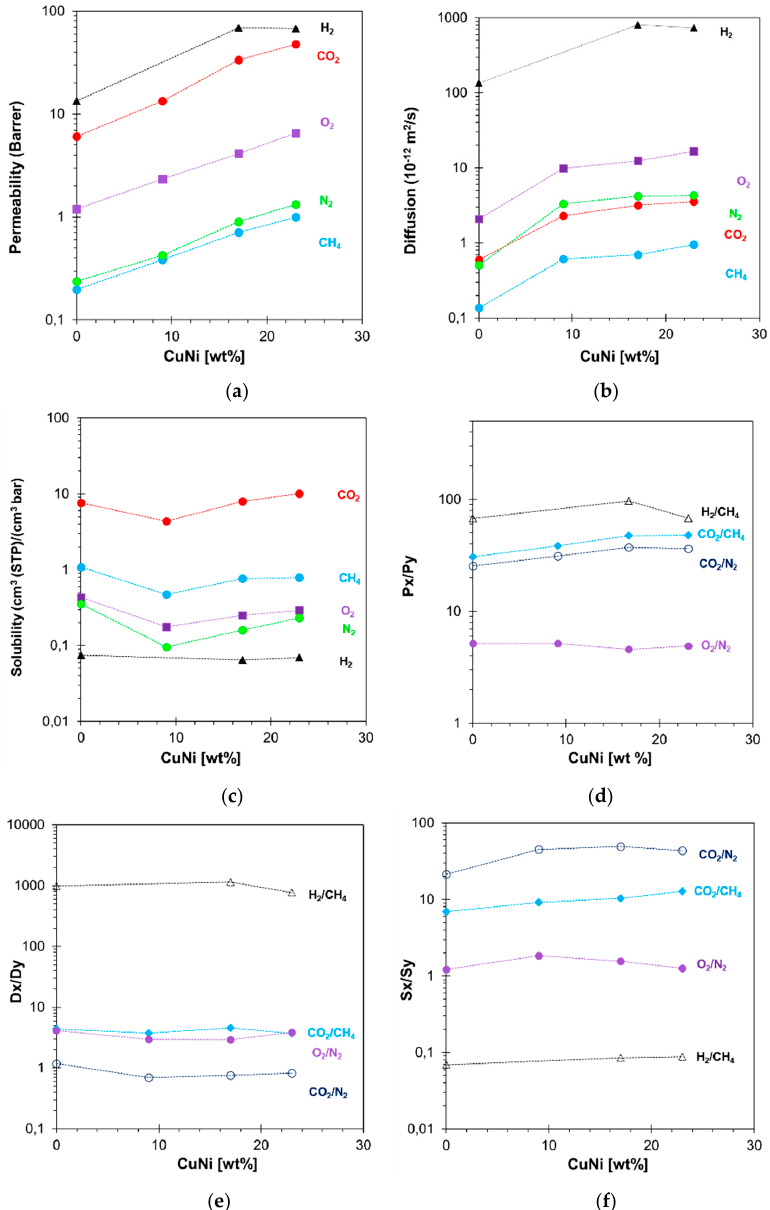
Figure 6. ( a ) Permeability, ( b ) diffusivity, ( c ) solubility coefficients, and respective N 2 selectivity ( d , e , f ) for each gas as functions of weight percentage of MOF loaded in PEEK-WC.